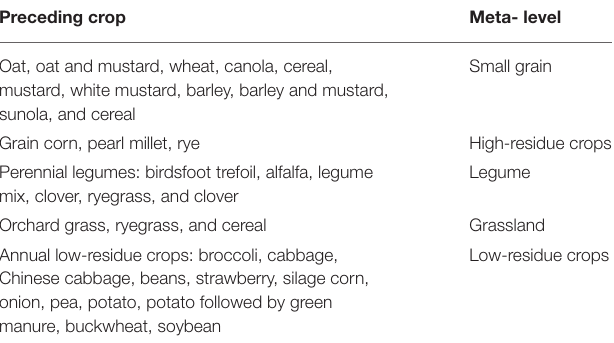
TABLE 2 | Classification of preceding